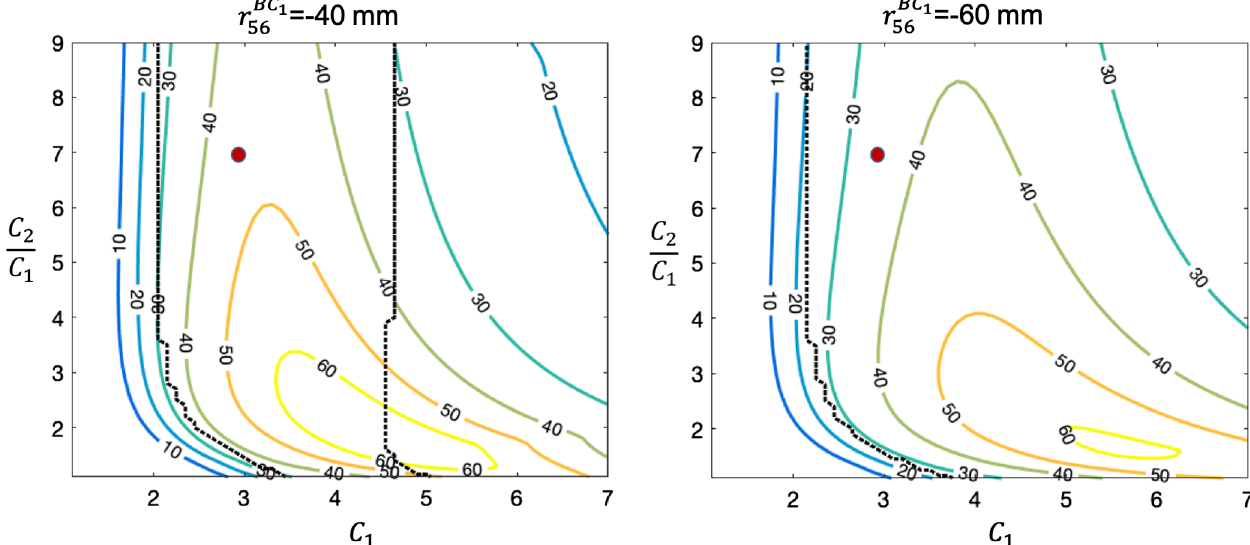
FIG. 5. The rf tolerance of the booster θ 1 ; 1 10 5 for two different compaction factors in BC 1 for the bunch charge of 500 pC compressed to the peak current of 5 kA. The red point shows the working point. The dashed black lines show the limits of the available rf